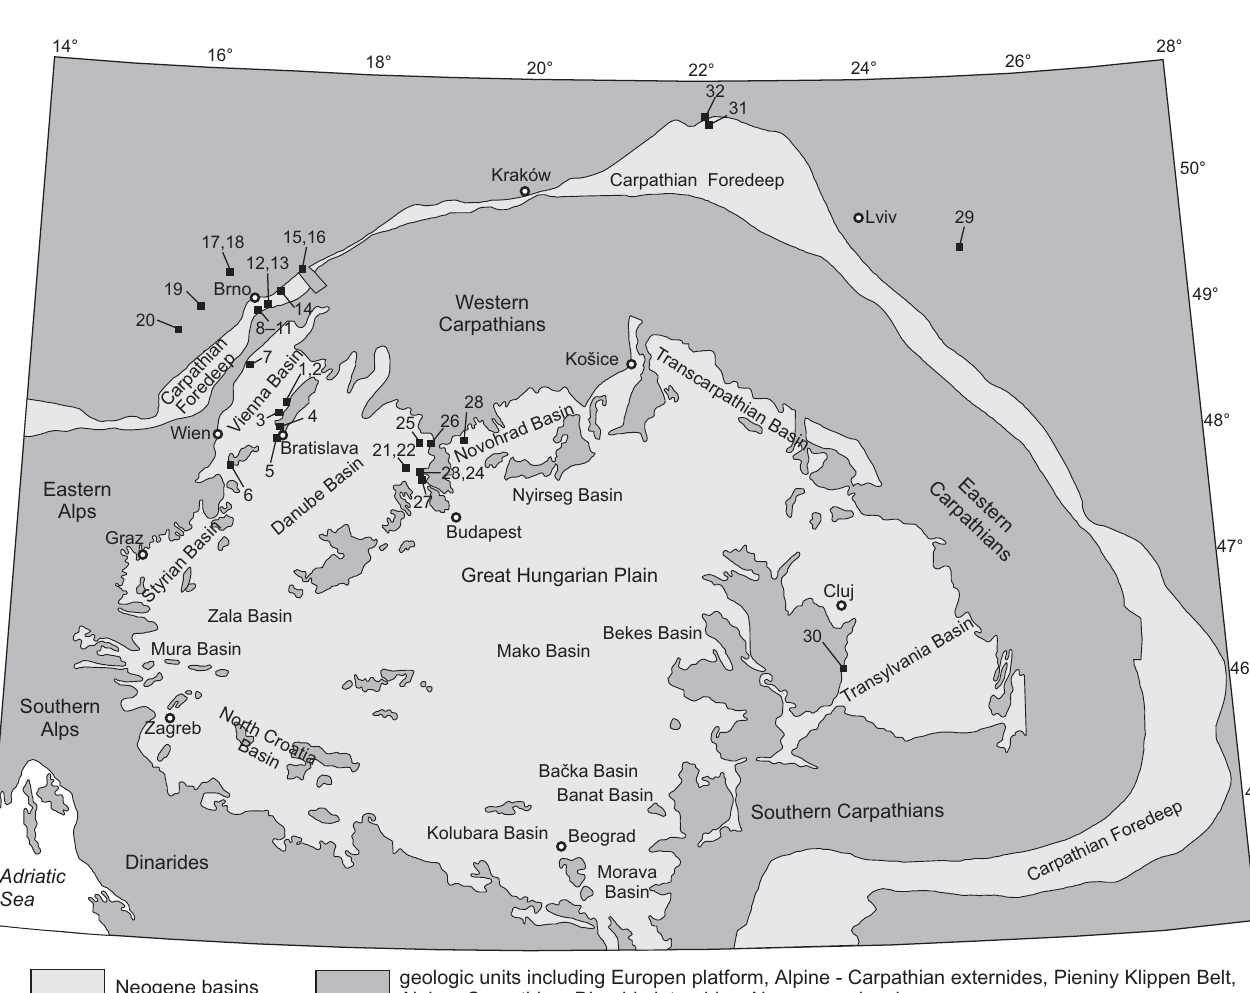
Fig. 1. Modified geographical and geological map of the studied area with Recent distribution of central Paratethyan deposits, redrawn from Ková č (2000). List of studied sites: 1, Rohožník; 2, Vývrat; 3, Stupava; 4, Devínska Kobyla; 5, Wolfsthal; 6, Müllensdorf; 7, Mikulov; 8, Židlochovice; 9, Blu č ina; 10, Rebešovice; 11, Telnice; 12, Pratecký Vrch; 13, Holubice; 14, Vyškov; 15, Hluchov; 16, P ř emyslovice; 17, Lomnice; 18,- Ochoz; 19, Kralice